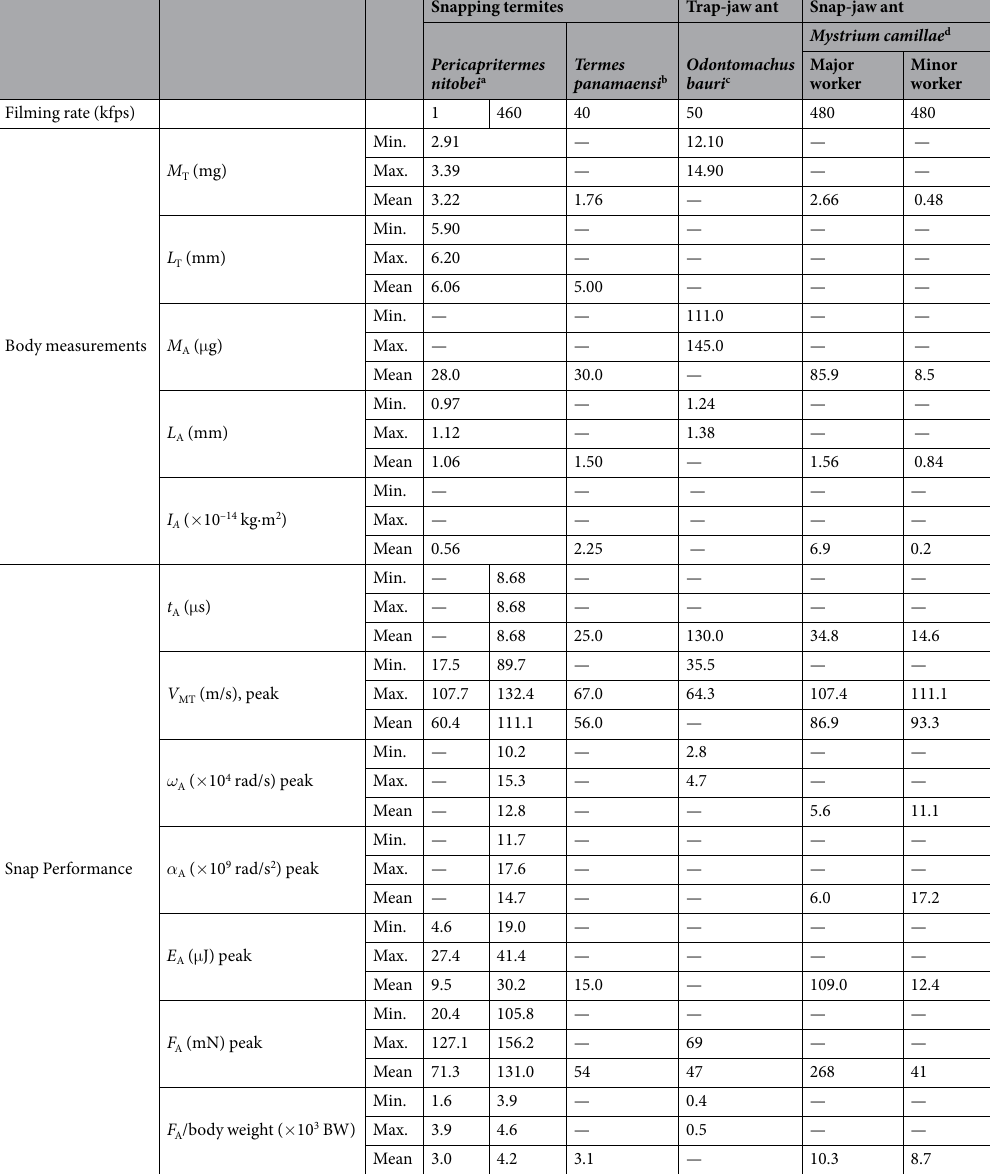
Table 1. Comparison of body measurements and snap performance between the snapping termites and ants. Body measurements: M T , body mass; L T , body length; M A , mass of the waving part of left mandible; L A , length of the waving part of left mandible; I A , the moment of inertia of waving part of the left mandible. Snap performance: t A , duration of mandible strike; V MT , velocity of the mandible tip; ω A , angular velocity of waving part of the left mandible; α A , angular acceleration of mandible strike (calculated as α A = ω A / t A ); E A , energy released by mandible strike; F A , force caused by mandible acceleration; F A /body weight, ratio of maximum striking force and body weight. a data from current study (see Tables S1, S2, and S3 in Electronic Supplementary Material); b data from Seid et al . 6 ; c data from Patek et al . 7 ; d data from Larabee et al . 5